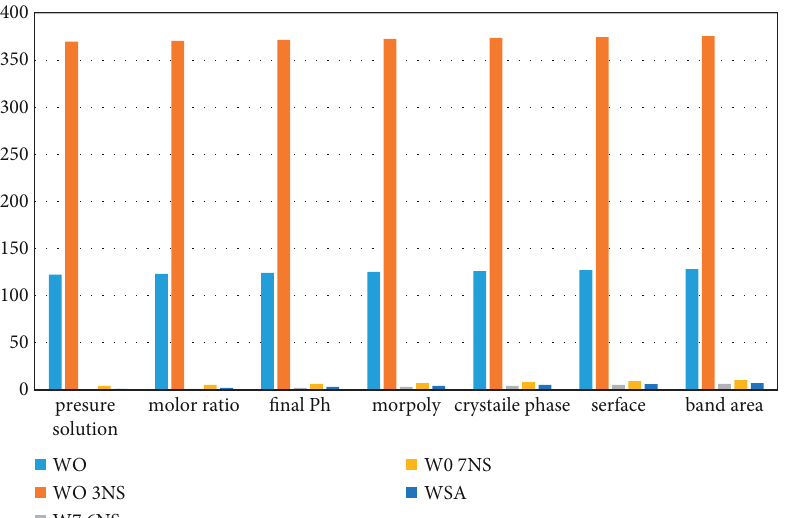
Figure 4: Selected synthesis parameters and characteristics for the different WO commercial Sigma Aldrich WO 3 (WSA).